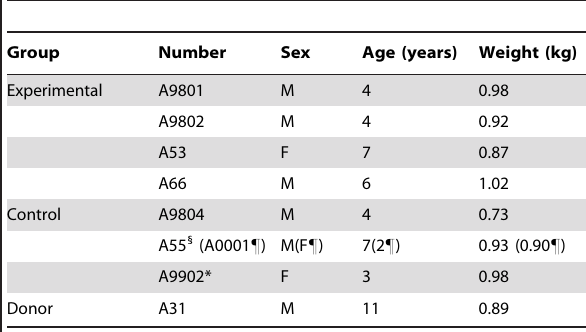
Table 1. Details of Aotus lemurinus griseimembra used for immunization and